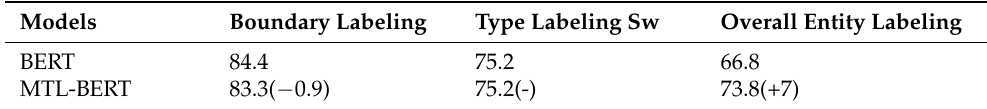
Table 8. Comparison of the performance of the BERT and MTL-BERT models regarding the separate F1 values of the two subtasks